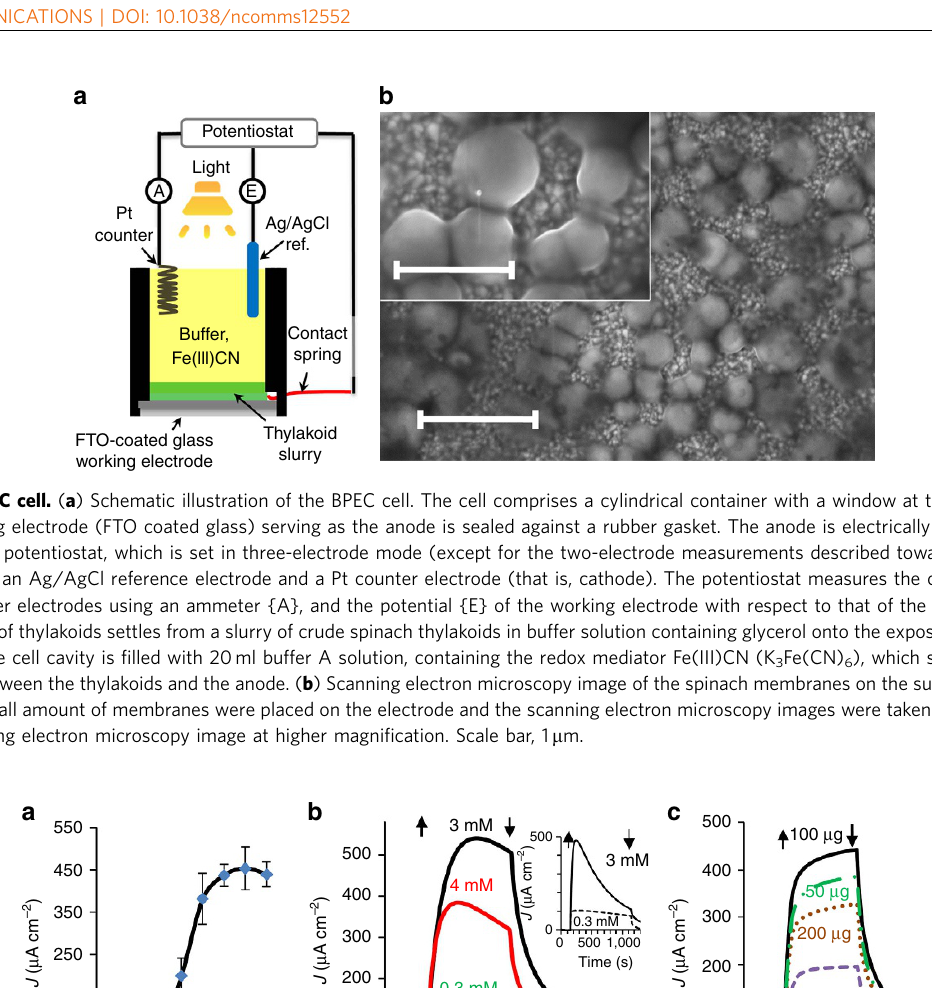
redox couple ferri/ferrocyanide (Fe(III)/Fe(II)CN) that extracts electrons from the photosynthetic membranes and transfers them to the anode. The photocurrent dependence on the applied potential is presented in Fig. 2a, showing saturation of 450 ± 50 m A cm (cid:2) 2 at an anode potential of 0.5 V Ag/AgCl . The measurements were carried out in buffer A solution with a thy- lakoid content of 0.1 mg Chl and a Fe(III)CN concentration of 3 mM. The dependencies of the photocurrent, measured at 0.5 V Ag/AgCl , on the Fe(III)CN concentration (at a thylakoid content of 0.1 mg Chl) and thylakoid content (at a Fe(III)CN concentration of 3 mM) are presented in Fig. 2b,c, respectively. A